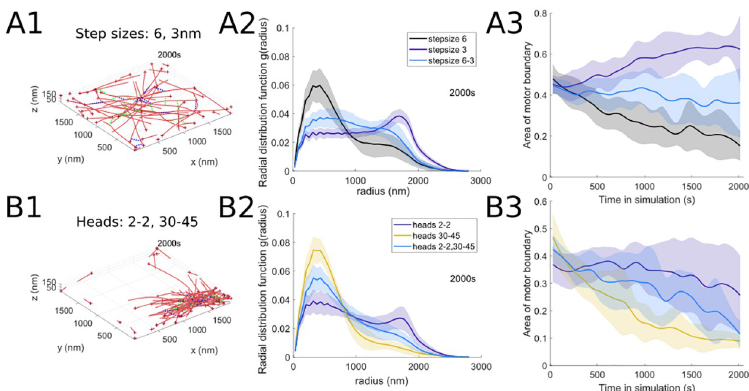
Fig 8. Two populations of motor proteins with different motor step sizes and motor heads result in actin filament organization that lies between the values expected from the motors acting individually. Sample final simulation snapshots ( t = 2000s; A1 and B1) and evidence of compromise in actomyosin network behavior in simulations with two motor populations with (A) different myosin motor step sizes (6nm and 3nm), and (B) different ranges for the numbers of myosin motor heads (min 2 to max 2 (2–2), and min 30 to max 45 (30–45)). Measures of radial distribution (A2 and B2) and area of the polygon bounding all motor proteins (A3 and B3) fall between the values calculated for the motor proteins acting alone (compare to Figs 5, 7A2 and 7B2). Unless otherwise indicated above, the parameter values used for both motors are d step = 6 nm, k head,bind = 0.2/s, F s = 100 pN, range heads = 15–30 (see Table 1). Solid lines indicate the average and shaded areas indicate the standard deviation over 10 stochastic